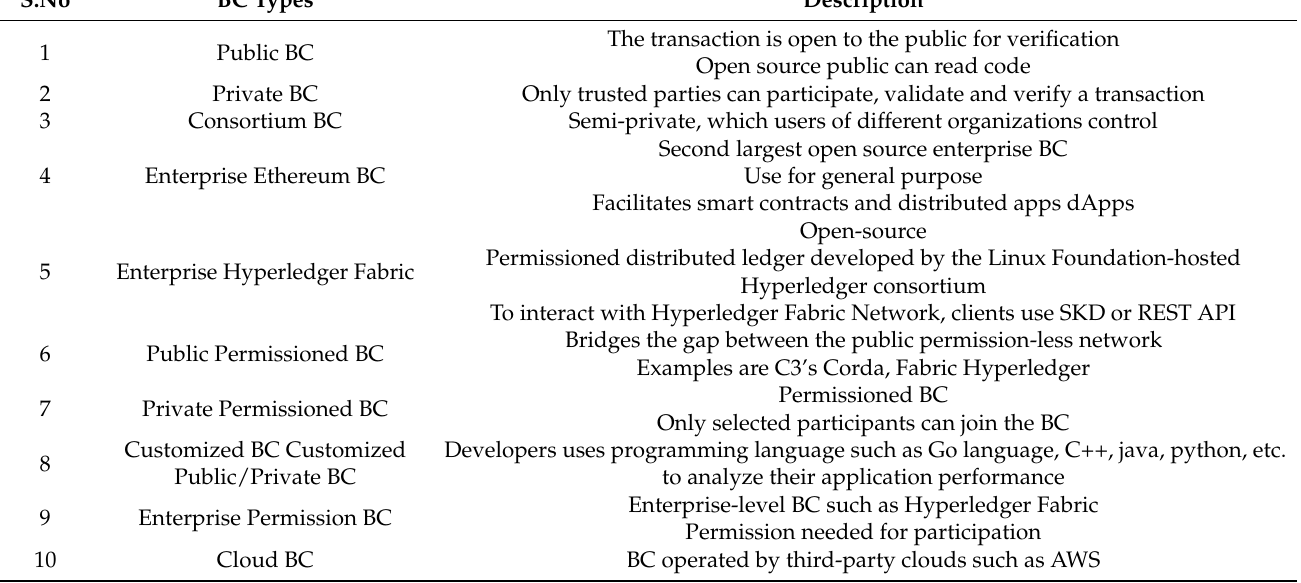
Table 3. Summary of known types of